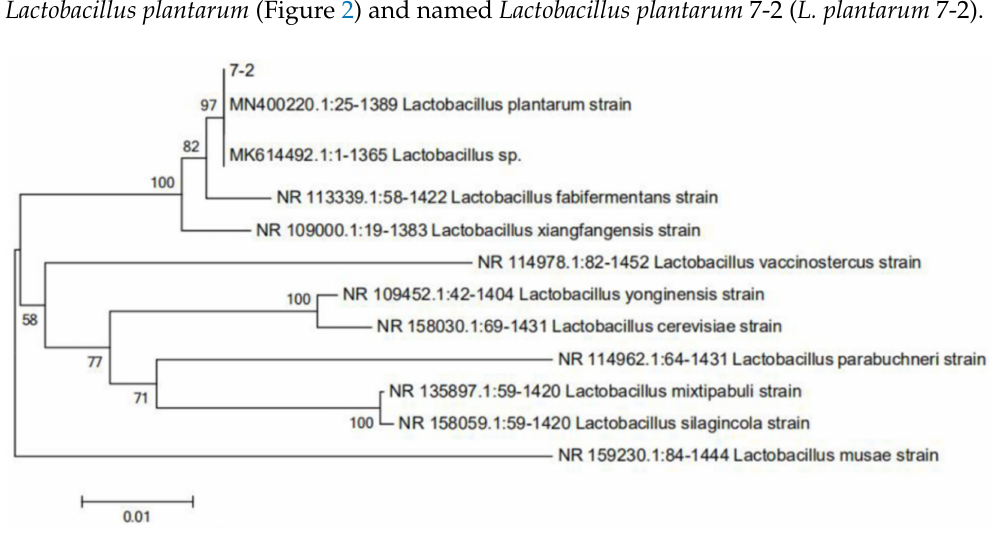
Table 1. Content of biogenic amines in dairy products fermented by L. plantarum 7-2 Biogenic amine content.